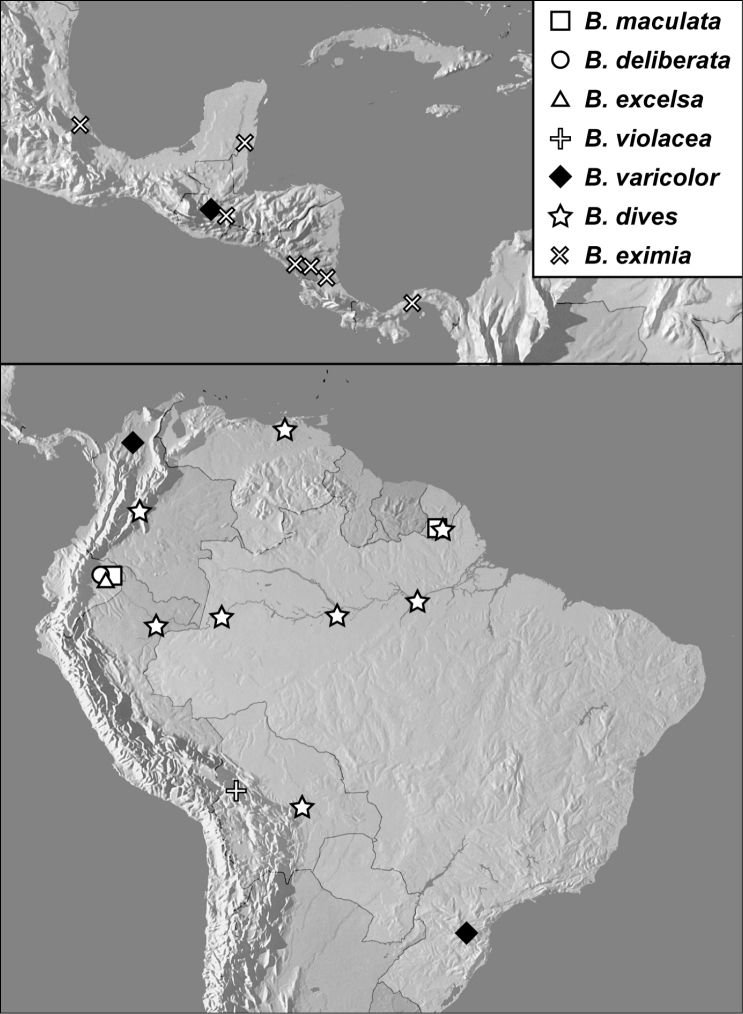
Baconia godmani group records. Record for Baconia varicolor in Colombia is a country record only.